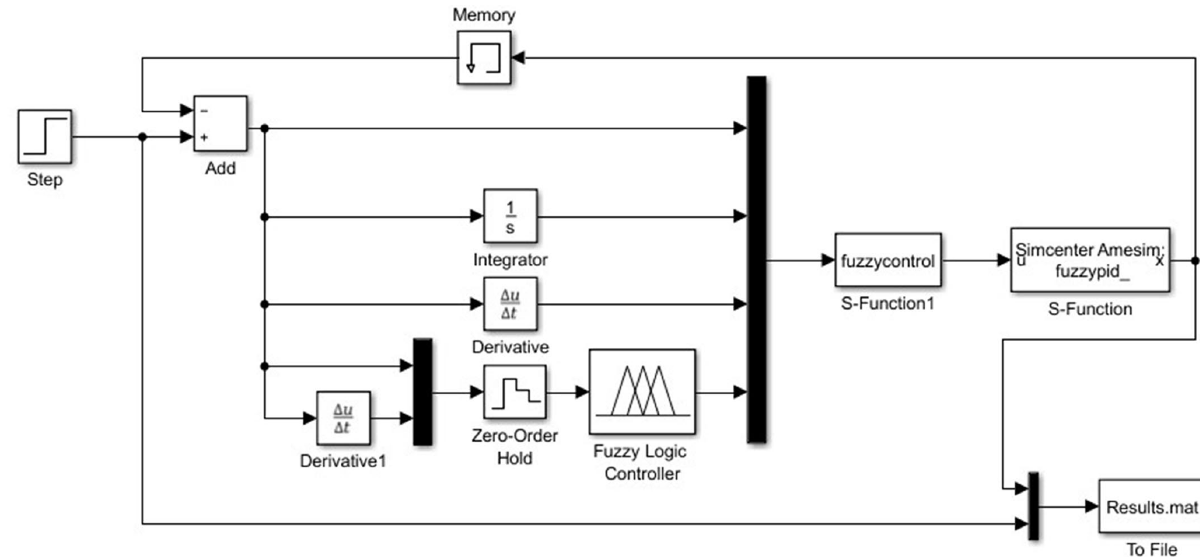
Figure 7. Simulation model of control system of the